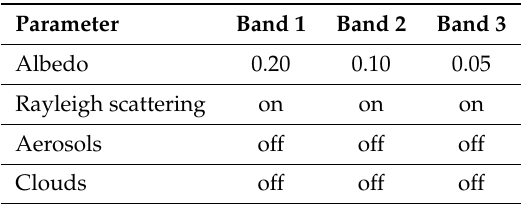
Table A4. Scattering parameters of scenario Rayleigh .